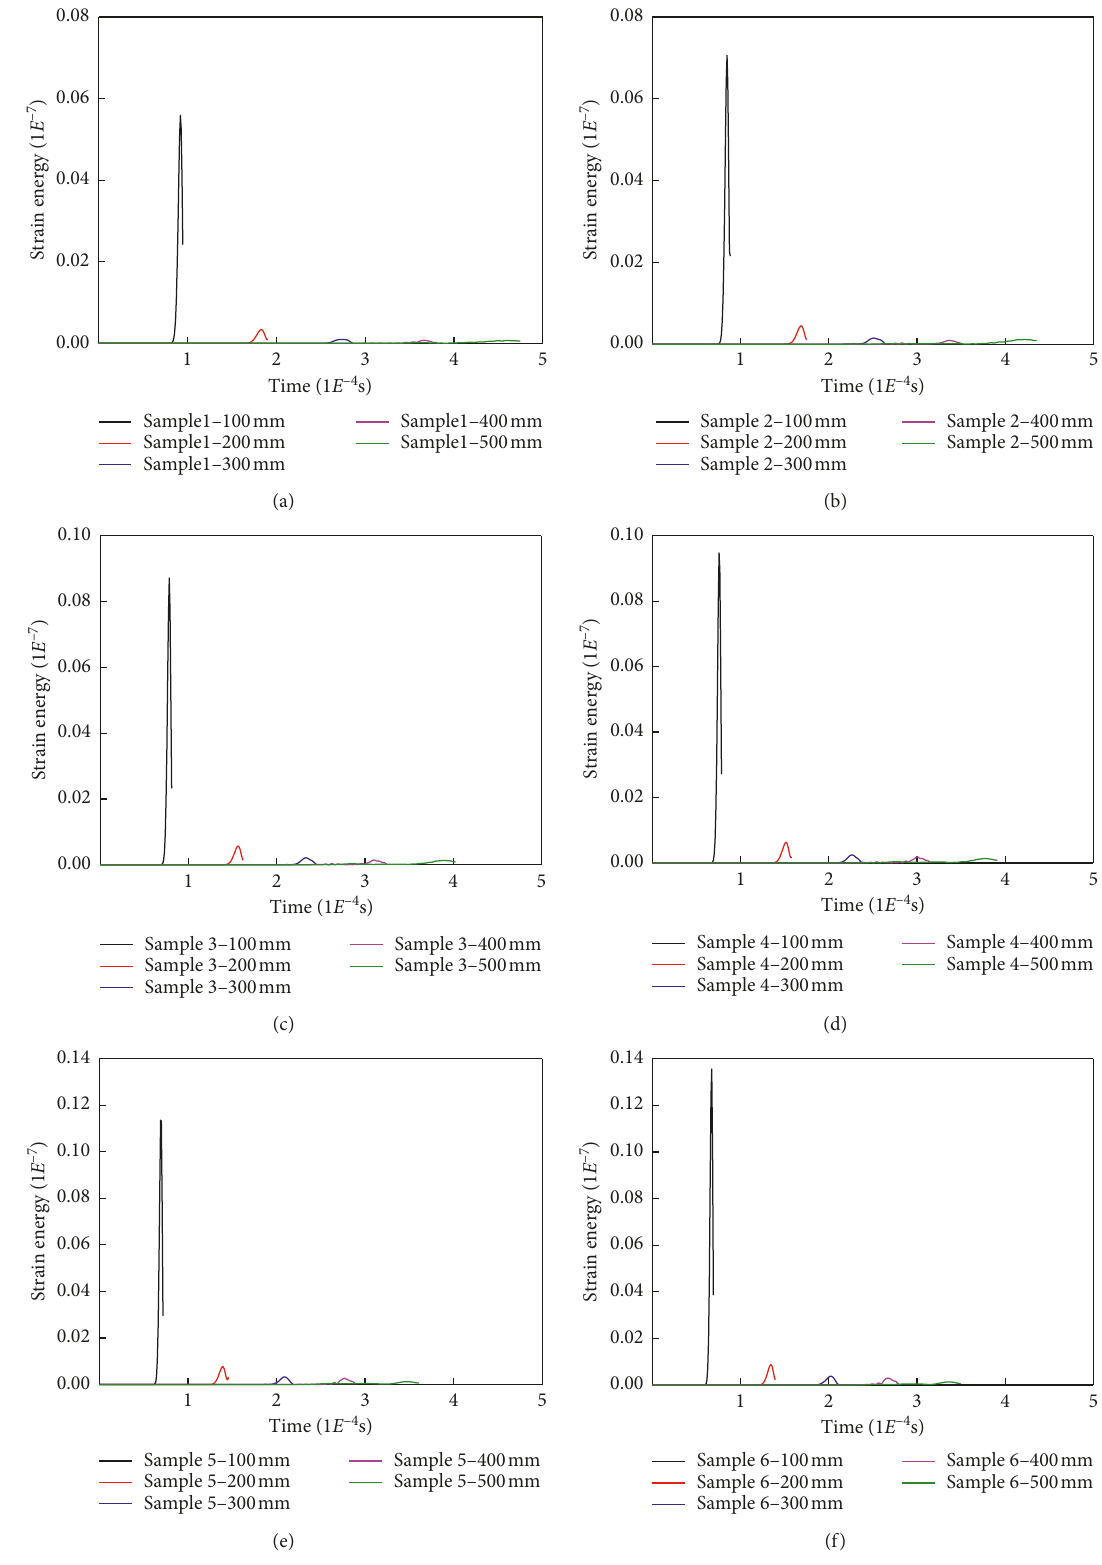
Figure 21: First appearance of strain energy: (a) Sample 1, (b) Sample 2, (c) Sample 3, (d) Sample 4, (e) Sample 5, and (f) Sample 6. When the measuring distance arrives at 500mm, the strain energy peak of the sample 1 becomes difficult to